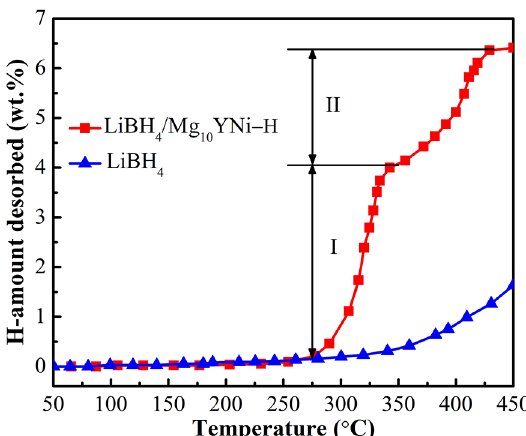
Figure 4. XRD patterns of the LiBH milled (a) and dehydrogenated at 350 (b) and 450 °C (c), respectively.